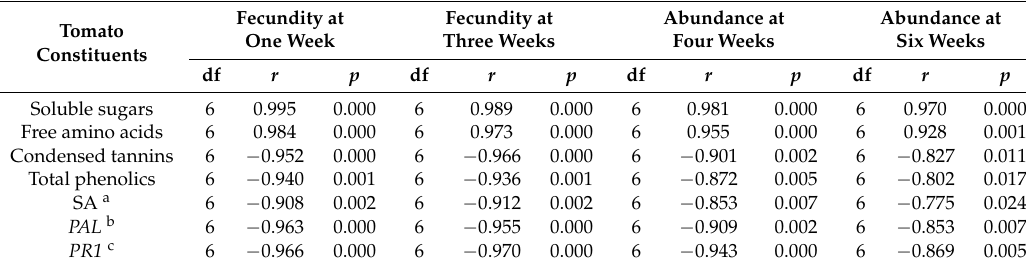
Table 3. Pearson correlations between B. tabaci fecundity (egg/pair) and abundance (number/plant) and biochemical properties of tomato